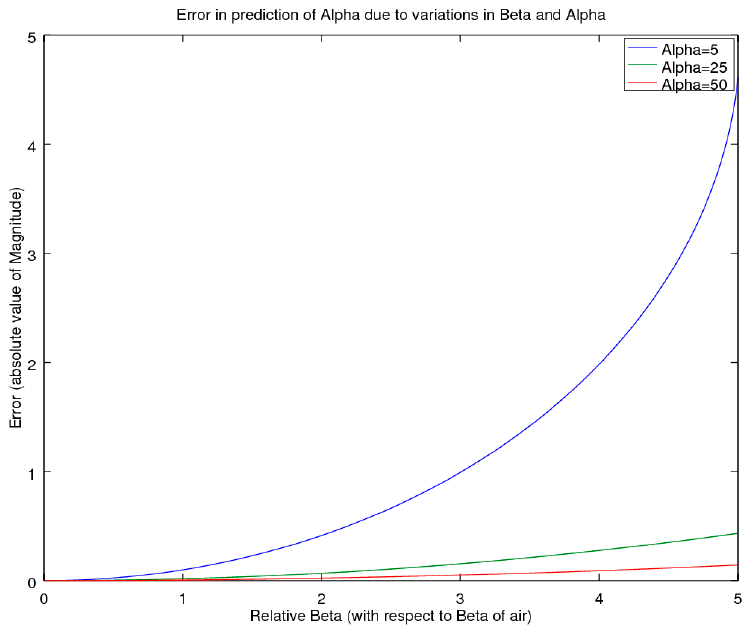
Figure 8. Error comparison for the CSMM simplified new method utilizing only pressure-magnitude readings |H 30 |. Error is reported as the magnitude of the absolute value of the error of the predicted value of α . Error magnitude was computed as material propagation changes occurred for both α and β (typical materials have a propagation delay with relative β < 1).